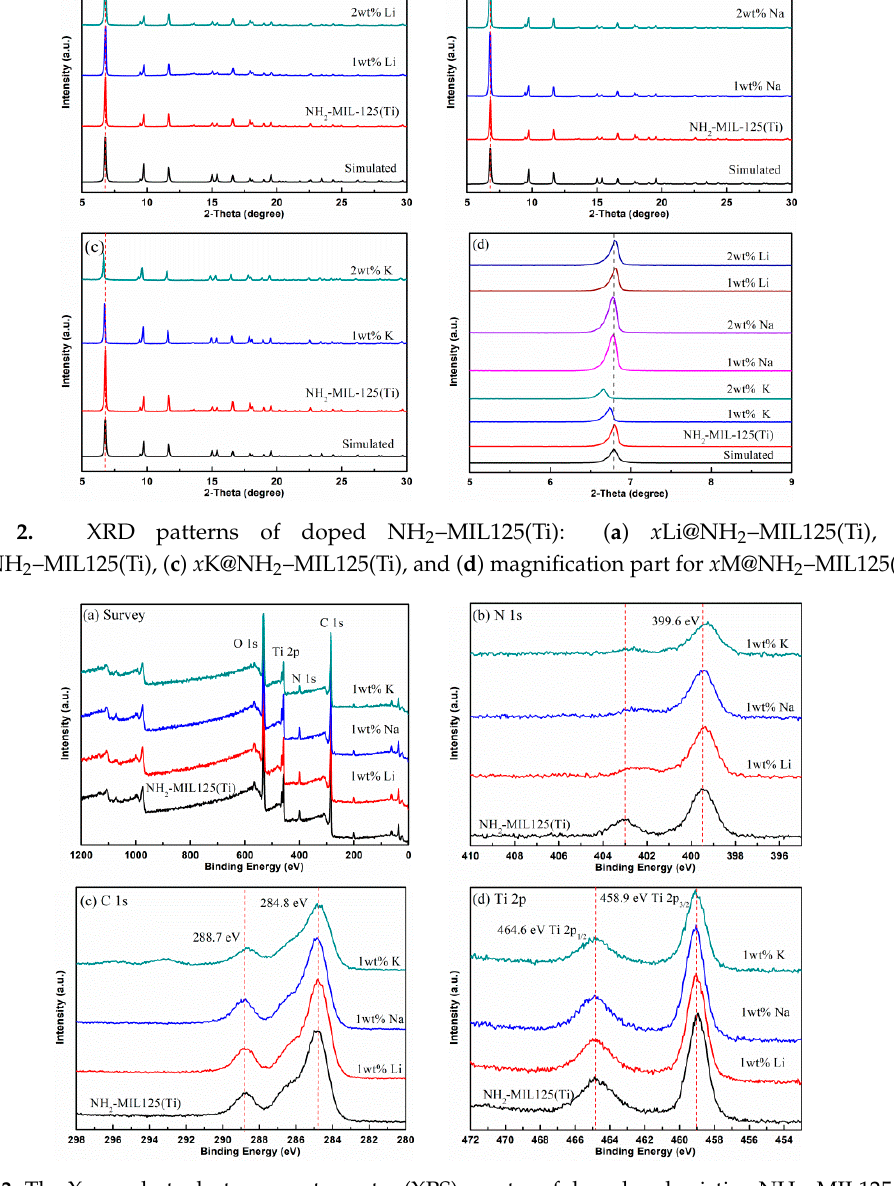
Figure 2. XRD patterns of doped NH 2 –MIL125(Ti): ( a ) x Li@NH 2 –MIL125(Ti), ( b ) x Na@NH 2 – MIL125(Ti), ( c ) x K@NH 2 –MIL125(Ti), and ( d ) magnification part for x M@NH 2 –MIL125(Ti).